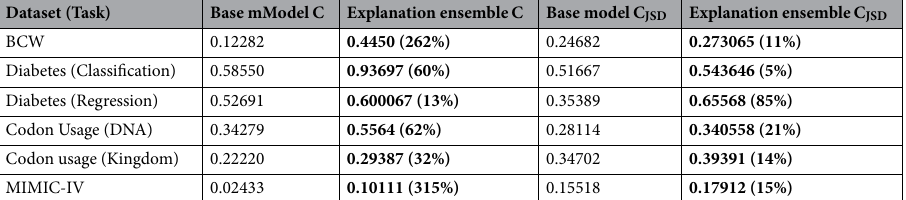
Table 4. Explanation Consistency ( C ) and JSD Explanation Consistency ( C JSD ) for the baseline models and explanation ensembles across all tasks tested. The percentage increase from baseline C ( C JSD ) to explanation ensemble C is shown in brackets. Significant values are in